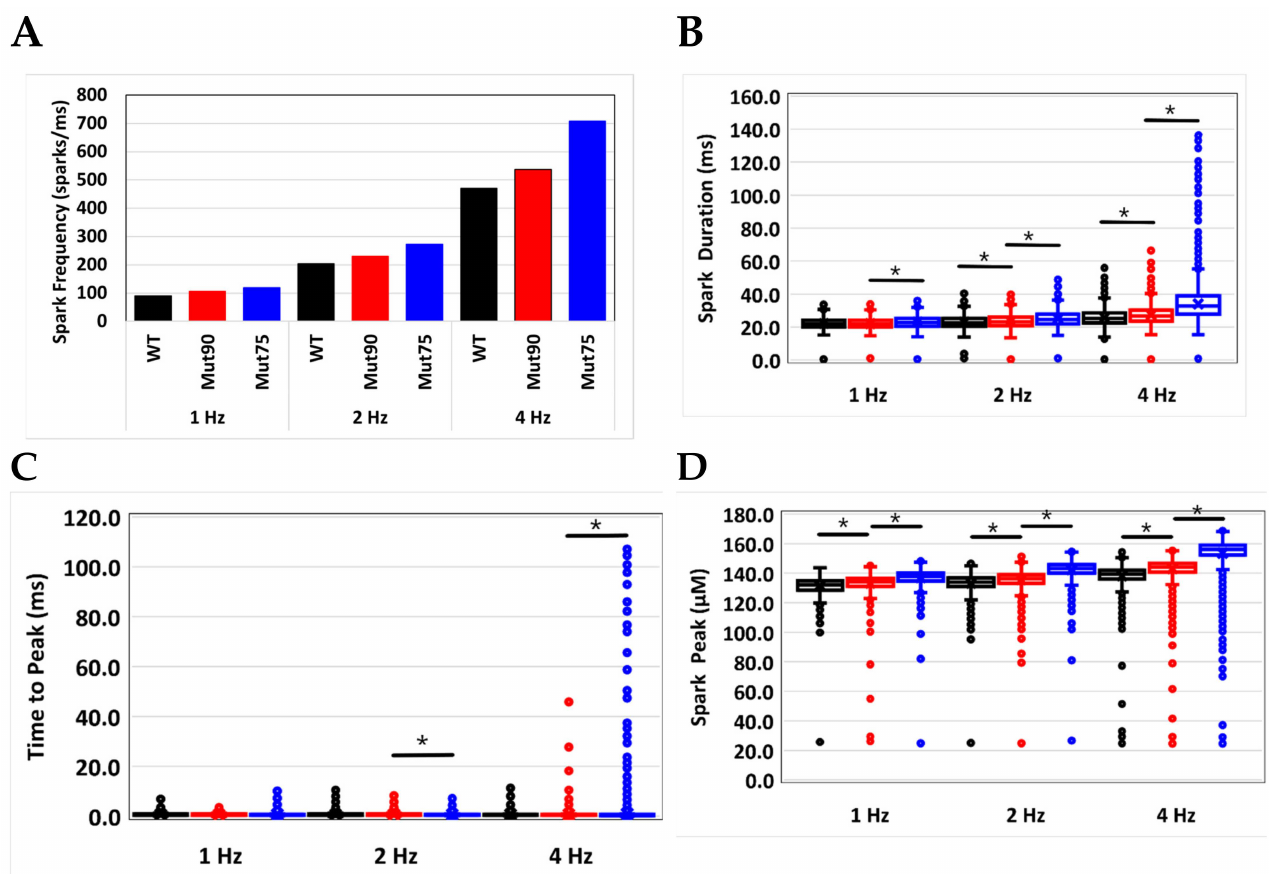
Figure 9. Calcium sparks in the cardiac myocyte at different pacing frequencies recorded for 1 s at steady-state pacing. ( A ) Spark frequency, ( B ) spark duration, ( C ) time to Ca 2+ spark peak, and ( D ) Ca 2+ spark peak amplitude. (Black—wild type, 75% of CDI transition rate—blue, and 90% of CDI transition rate—red). The box and whiskers plots show the middle two quartiles with boxes, the upper and lower quartiles with lines, the mean with an × , and outliers with points. Statistical significance at the p < 0.001 significance level for the student’s t -test for equality of means with samples of unknow variance is indicated by the black bars with asterisks. Shown are representative simulations out of six repeated simulations with different random number seed values in each case. The different simulation traces for each condition overlap at steady-state pacing. The number of data points for each simulation is equivalent to number of sparks is 1000 × the values shown in ( A ). Only the data for 10% of the 20,000 Ca 2+ release sites are not shown because it is impractical to store the large amount of